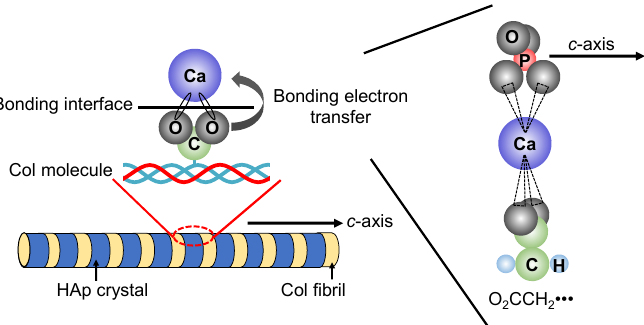
Figure 6. Possible interfacial state between HAp and Col.